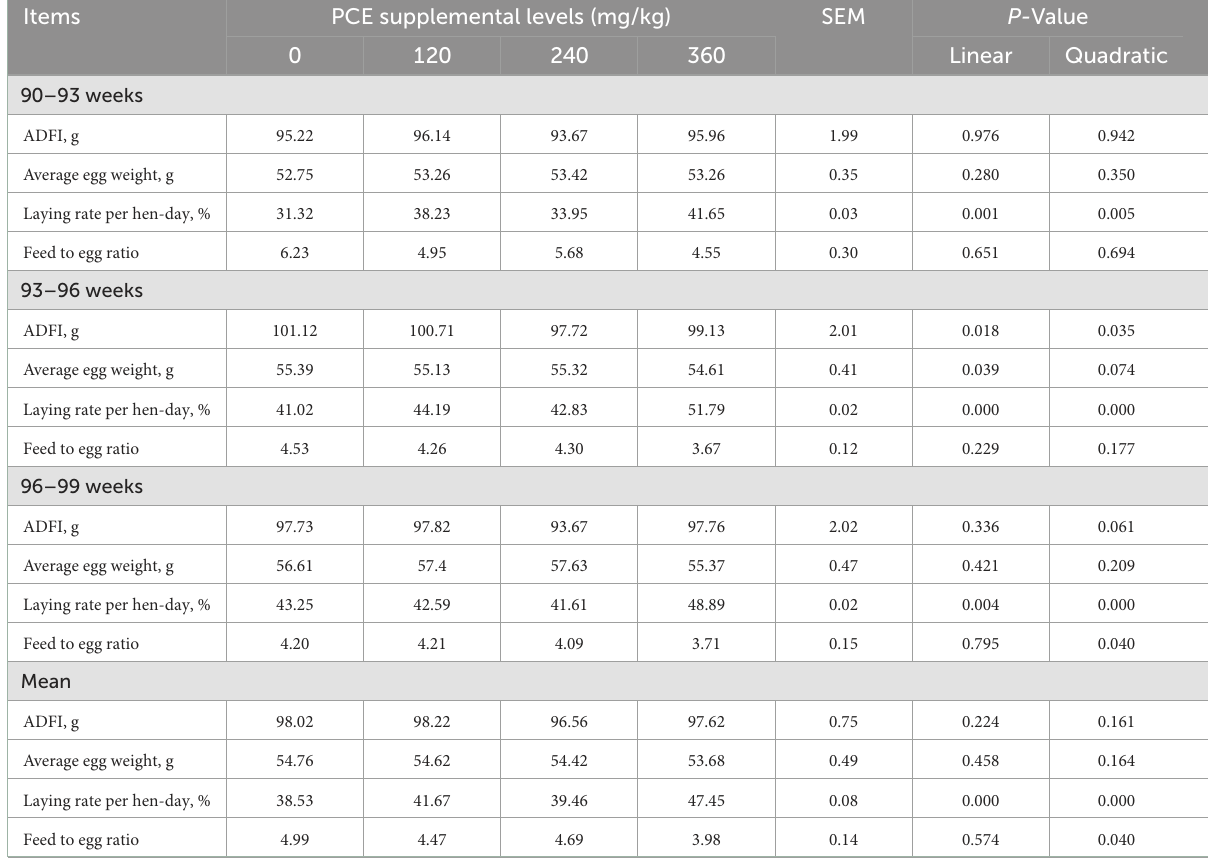
TABLE 2 Effect of purple corn extract on performance in laying